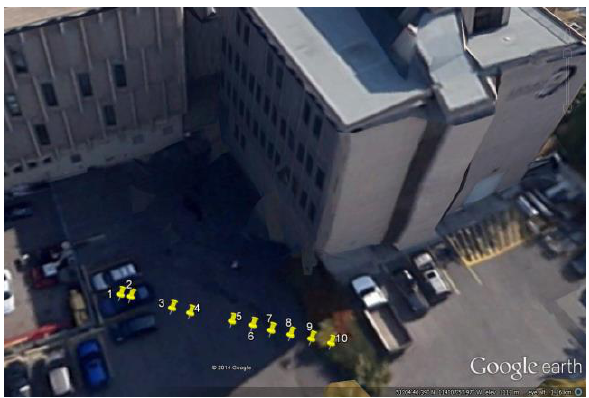
Figure 7. GPS positions of the chosen images